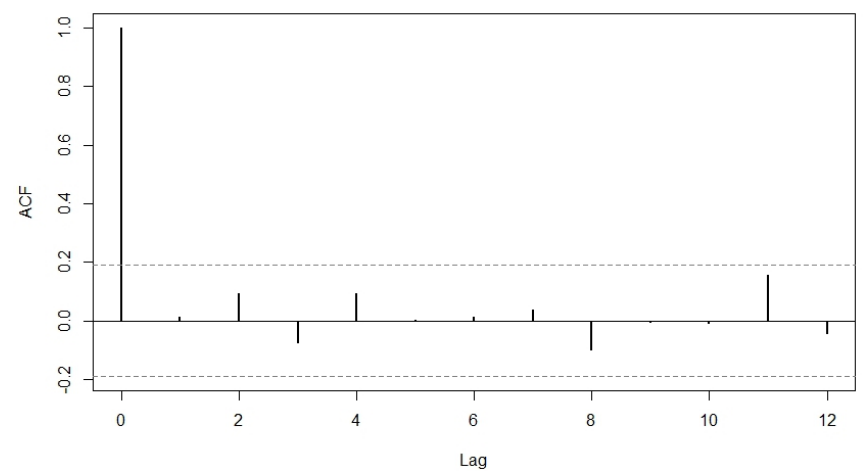
Figure 8. The ACF of the Pearson residuals (13) for the strikes